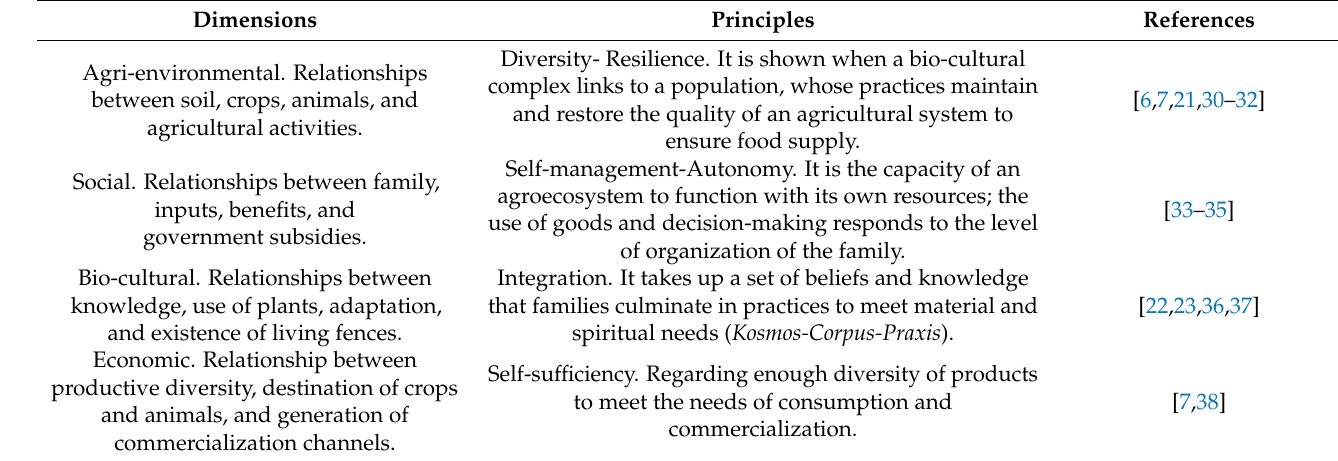
Table 1. Dimensions and principles for evaluating the sustainability of home gardens. Dimensions